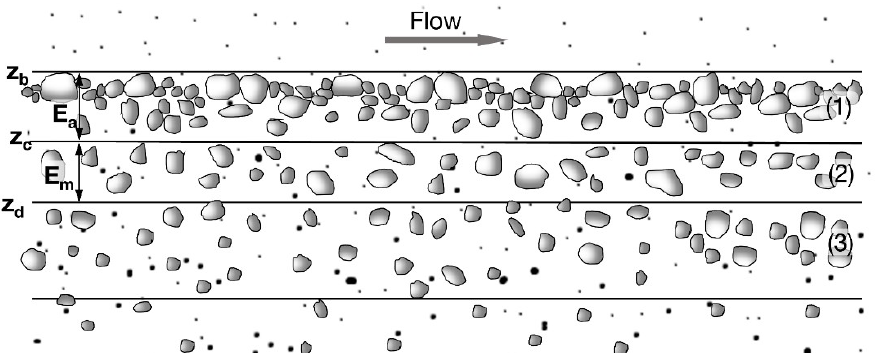
Figure 2. The structure diagram of the vertical cross‐section is based on the multi‐layers model. (1) = active layer; (2) and (3) = substrate layers; E a and E m = Active layer thickness and active‐stratum layer thickness; z b = bed elevation; z c and z d = substrate elevations.